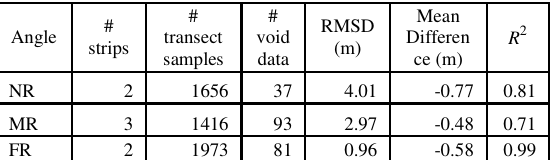
Table 5. Comparison of h spc for 5,045 sample points located along transect lines of slopes <10 ° across all three incidence angles for the Ely site, generated from single-pass X-HH InSAR compared to NEXTMap X-HH InSAR (multi-pass).